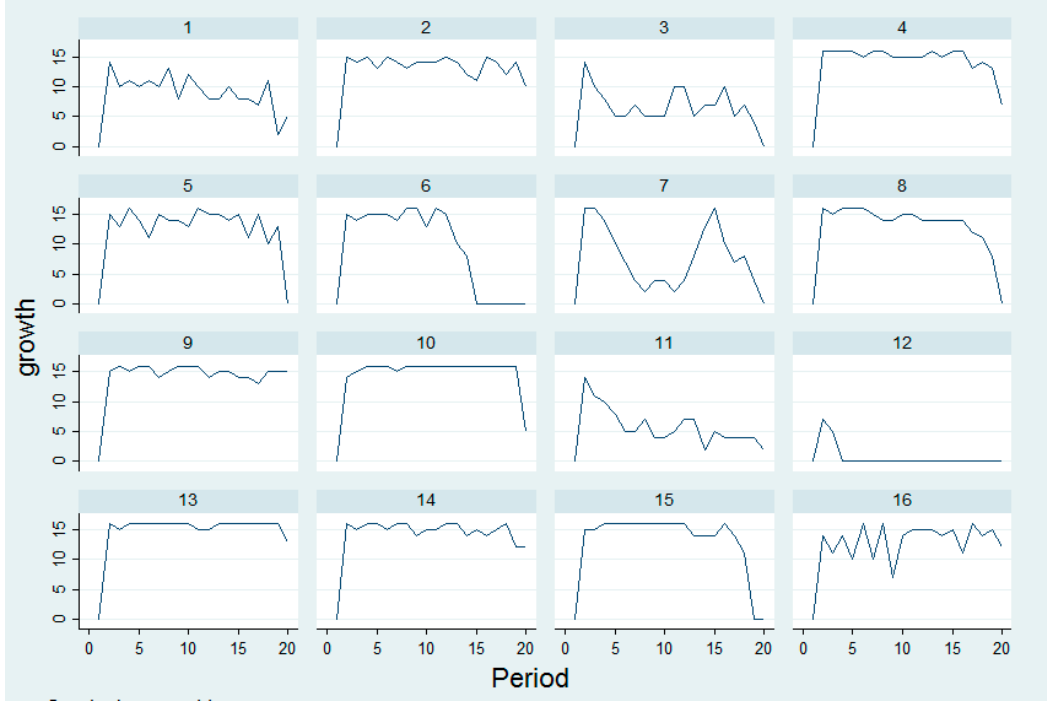
Figure A4. Growth prior to the start of each round (for all 16 groups).